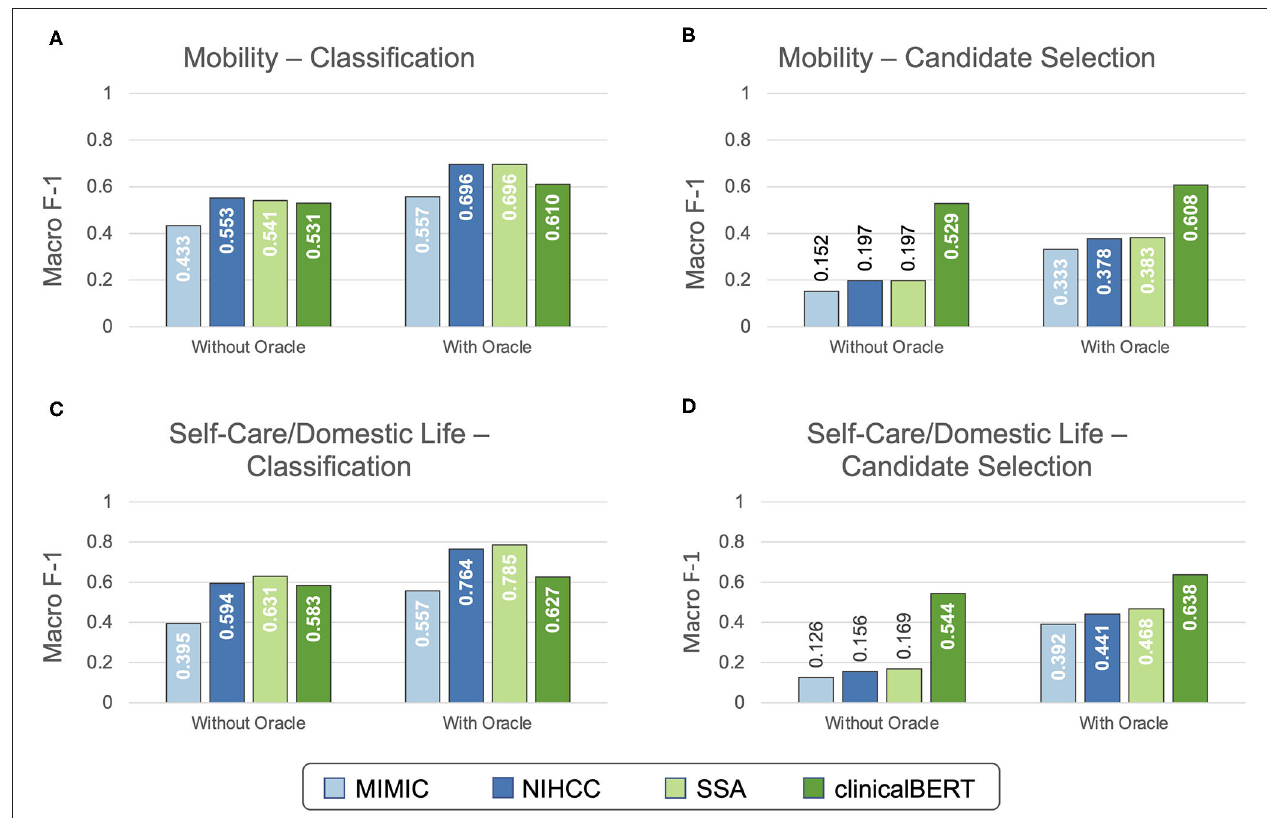
FIGURE 4 | Development experiment results for selecting word embeddings. Development set performance (macro-averaged F-1 with 10-fold cross validation) is shown using each embedding strategy for both Mobility (A,B) and Self-Care/Domestic Life (C,D) data, using both classification (A,C) and candidate selection (B,D)